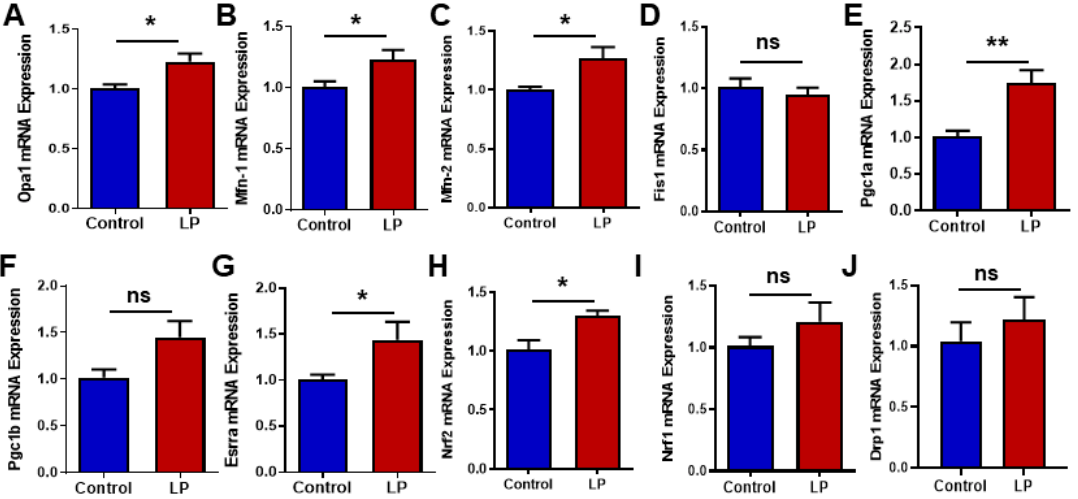
Figure 5. Effects of LP programming on the expression of the genes involved in mitochondrial dynamics and biogenesis in the liver of the control and LP rats. The mRNA levels of mitochondrial dynamic